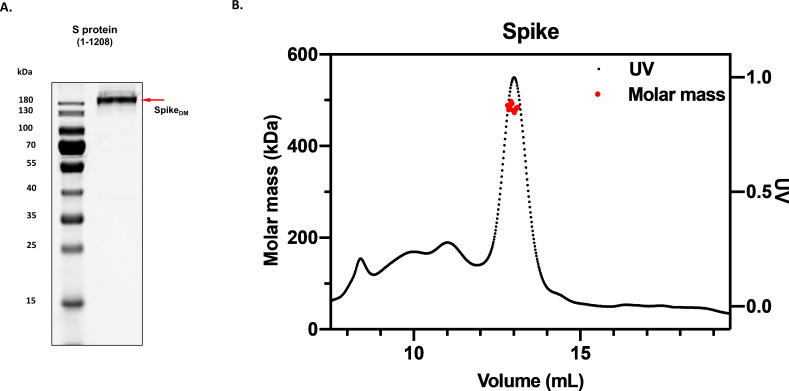
Homogeneity of spike (S) protein.(A) Images of denaturing polyacrylamide gel electrophoresis of purified S protein (1–1208) is shown along with its molecular size highlighted with red arrow, alongside protein standards. (B) Molecular weight analysis of purified S (1–1208) by size exclusion chromatography – multiple angle light scattering with measured molecular weight of 484.2 (kDa) (±4.9%).